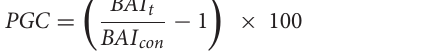
Frontiers in Forests and Global Change |